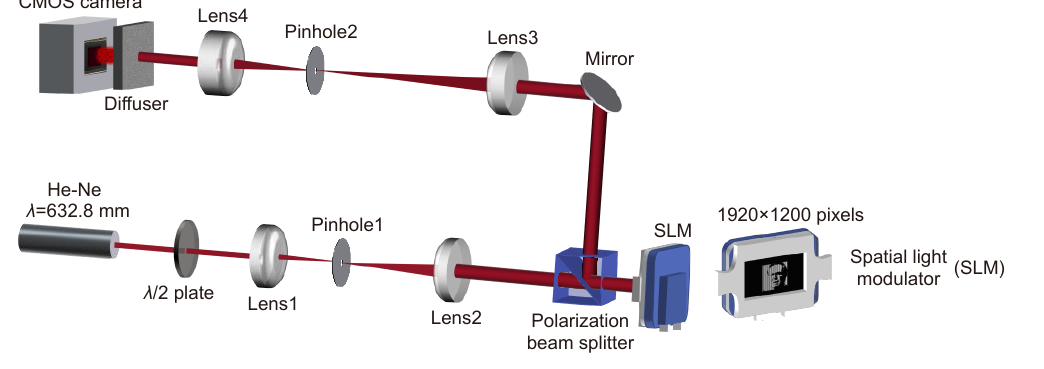
Fig. 4 | Experiment set-up.